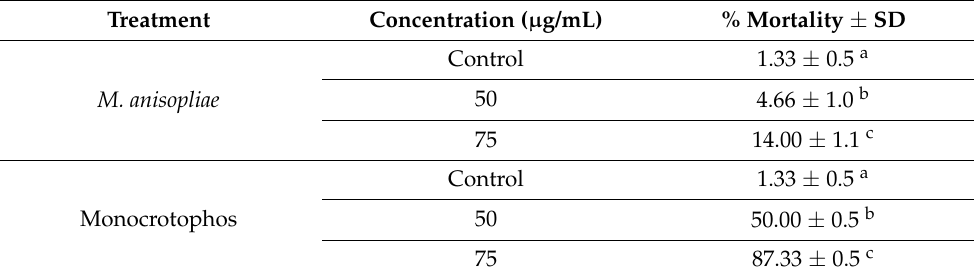
Table 3. Mortality of E. eugeniae after the treatment of M. anisopliae crude extract and Monocrotophos at post 24 h treatments. The identical lower case letters do not differ significantly ( p >